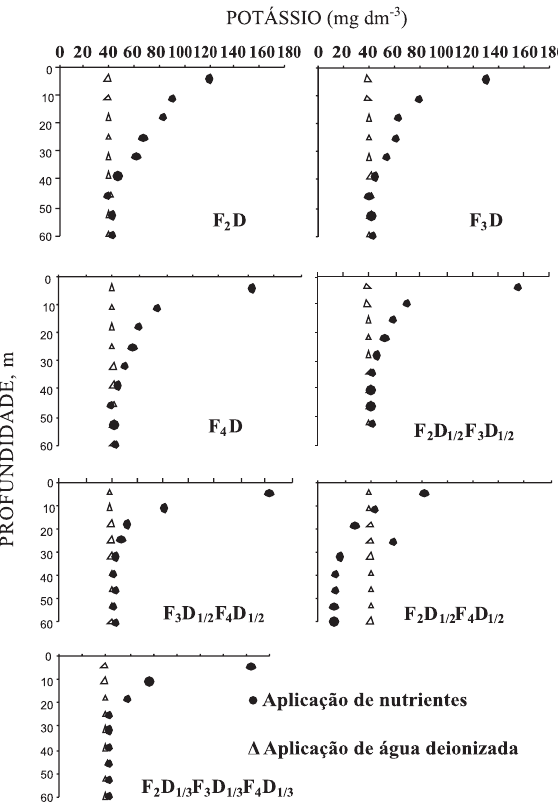
Figura 4. Teores de potássio ao longo de colunas com amostras do LVdf, considerando a fração da lâmina de irrigação (F) em que o nutriente foi aplicado em dose integral (D) ou fracionado em ) ou em três vezes (D ). duas (D 1/2 1/3